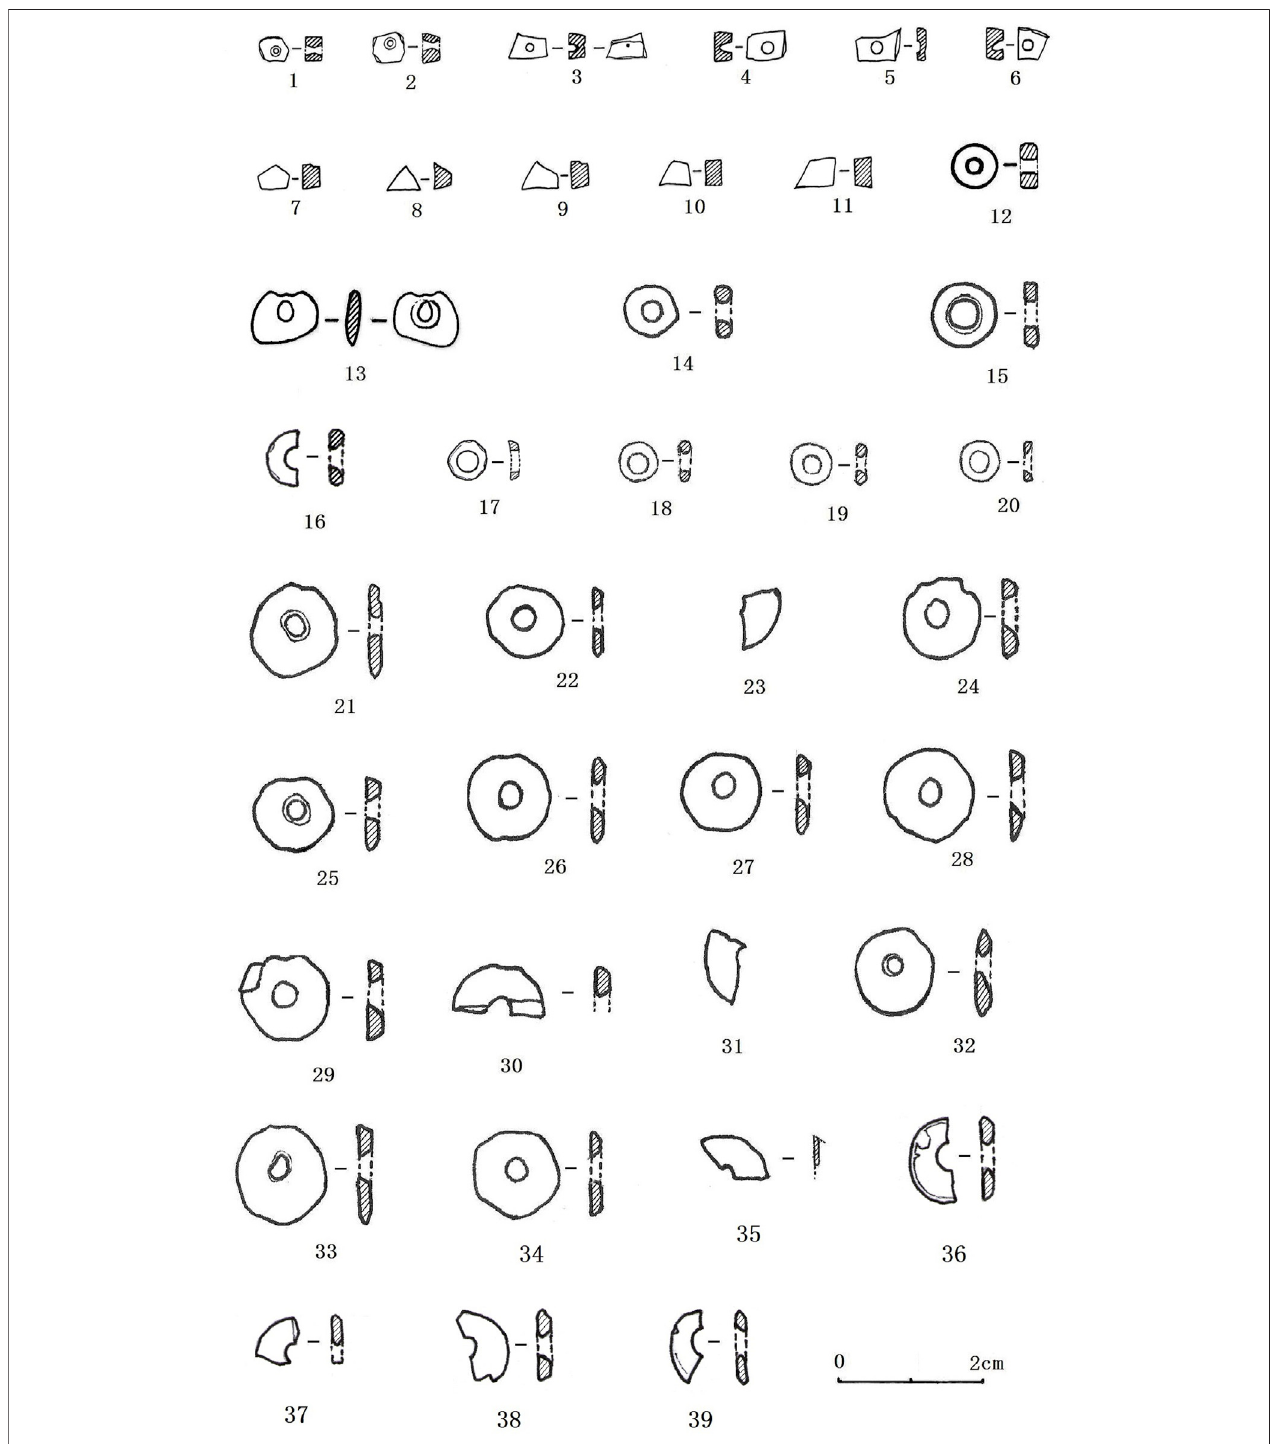
FIGURE 2 | Perforated OES ornaments identi fi ed at localities of the Late Paleolithic Shizitan site. 1, 2. Perforated beads from SZT9 Layer 4; 3 – 6. Semi-perforated beads from SZT9 Layer 4; 7 – 11. Broken pieces from SZT9 Layer 4; 12. Used bead from SZT12G; 13. Heavily used pendant from SZT24; 14 – 15. Used beads from SZT29 Layer 2; 16. Used bead from SZT29, Layer 7 upper contact; 17 – 20. Used beads from SZT29 Layer 7 Spits 2 – 1; 21 – 39. Used pendants from SZT29 Layer 7 Spits 5 – 2.